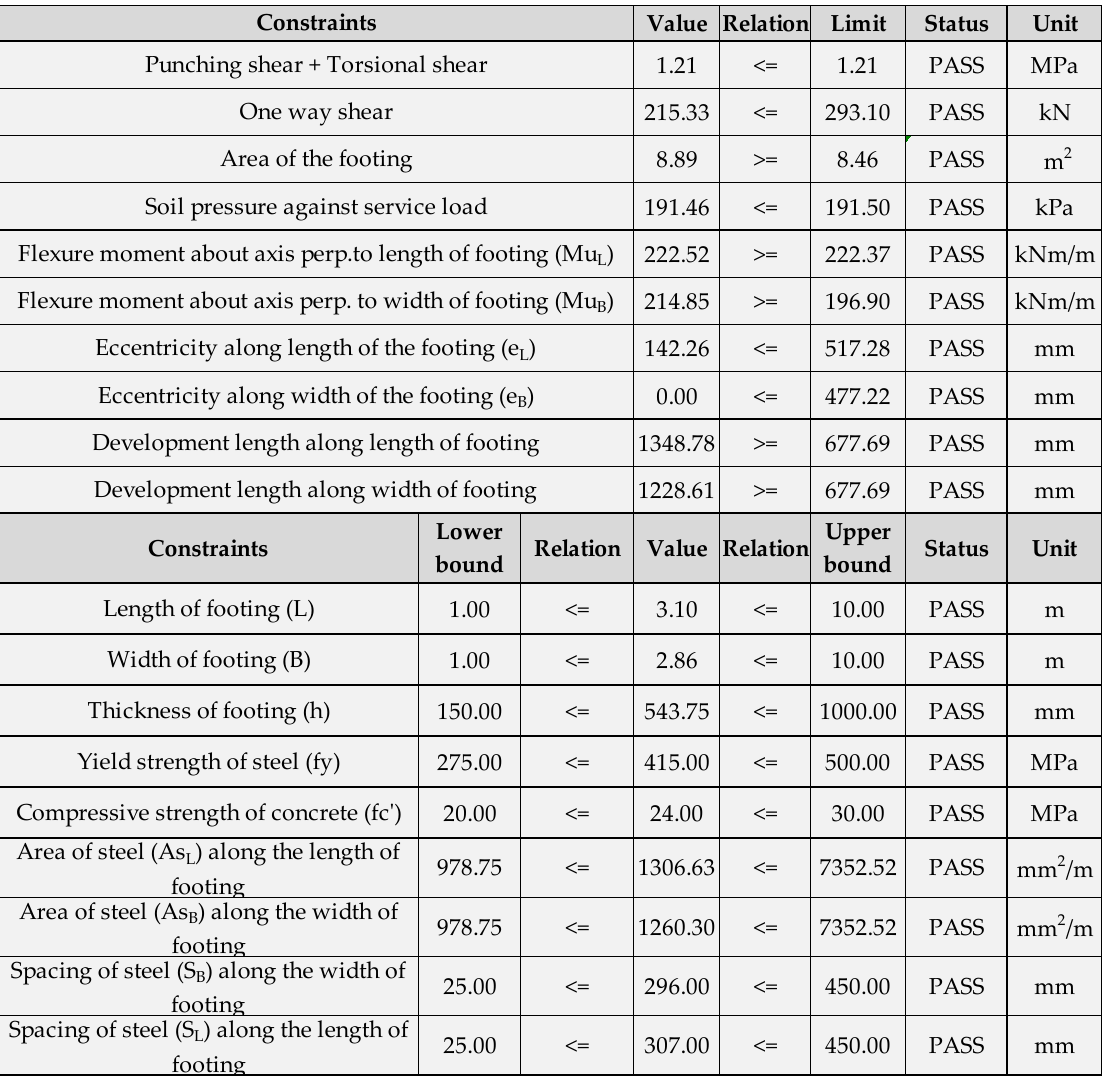
Figure 6. Constraint’s data sheet with single and both sided limits.